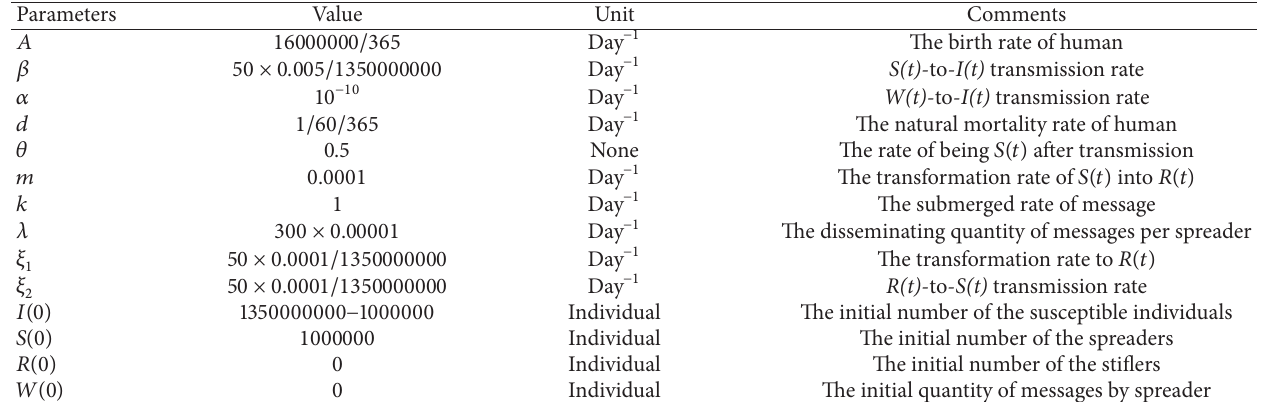
Table 1: Description of parameters in the system